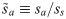
Bet-hedging region in temporally varying environments.Optimal strategy α* as a function of growth rates s˜a≡sa/ss and s˜b≡sb/ss for range expansions in temporally varying environments under the limits of environmental change rate (A) k → 0, see Eq (7), and (B) k → ∞. In all panels, lines delimit the bet-hedging region 0 ≤ α* ≤ 1. Two dots in the panels mark parameter values chosen for the analysis of Figs 3, 4 and 5.